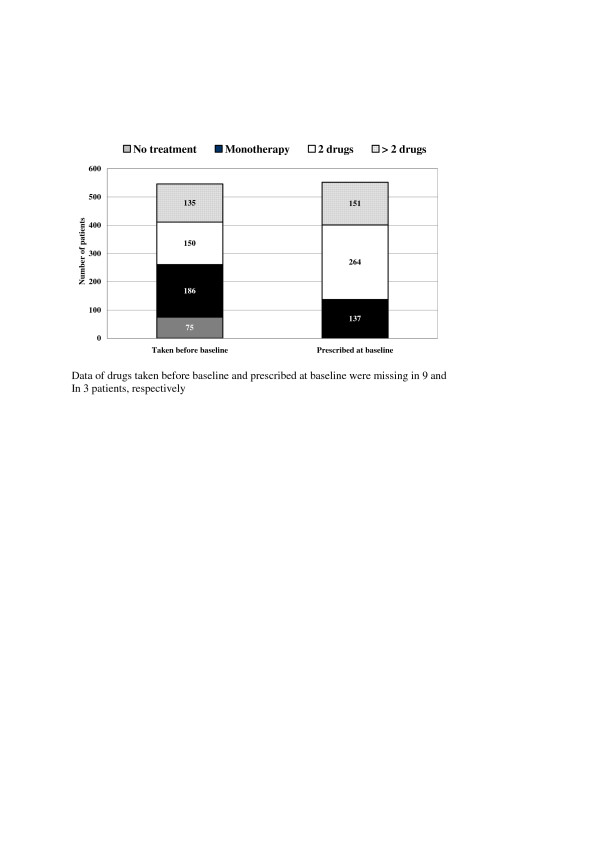
Distribution of patients according to the number of psychotropic drugs taken before/prescribed at baseline. Data of drugs taken before baseline and prescribed at baseline were missing in 9 and in 3 patients, respectively.